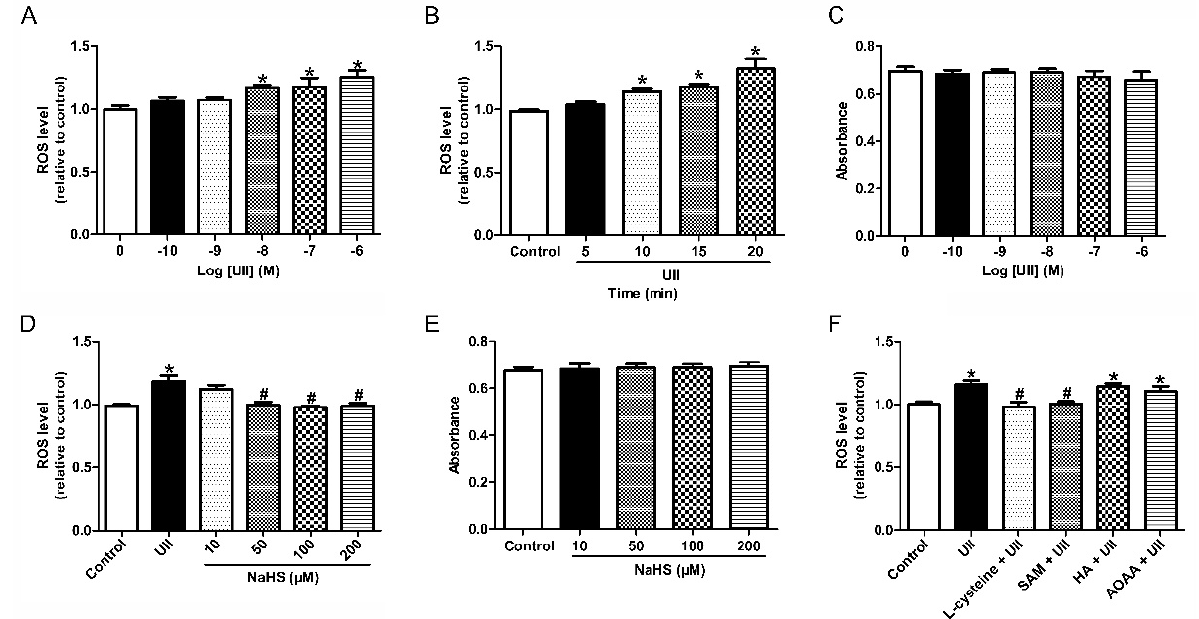
Figure 7. Effect of H 2 S on UII-induced increase in ROS level in SH-SY5Y cells. Bar graphs summarizing ROS level after treatment with various concentrations of UII (10 − 6 , 10 − 7 , 10 − 8 , 10 − 9 or 10 − 10 mol/L, ( A )). ROS levels were determined after pretreated SH-SY5Y cells with UII (10 − 8 mol/L) for different times (5, 10, 15, and 20 min, ( B )) or various concentrations of NaHS (10, 50, 100, or 200 μ mol/L) for 30 min ( D ). Cell viability was measured by the CCK-8 assay ( C , E ). ROS levels were determined after pretreated SH-SY5Y cells with L-cysteine (1 mmol/L), SAM (200 µ mol/L), or HA (10 mmol/L) before UII (10 − 8 mol/L) treatment ( F ). n = 6 in each group. * p < 0.05 vs. aCSF group; # p < 0.05 vs. aCSF + UII